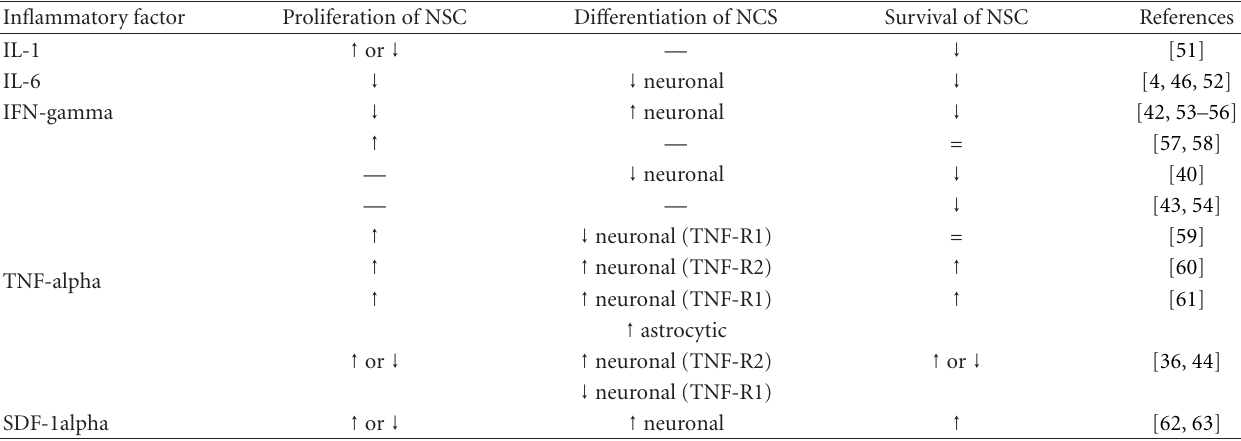
Table 1: Regulation of adult neurogenesis by inflammatory